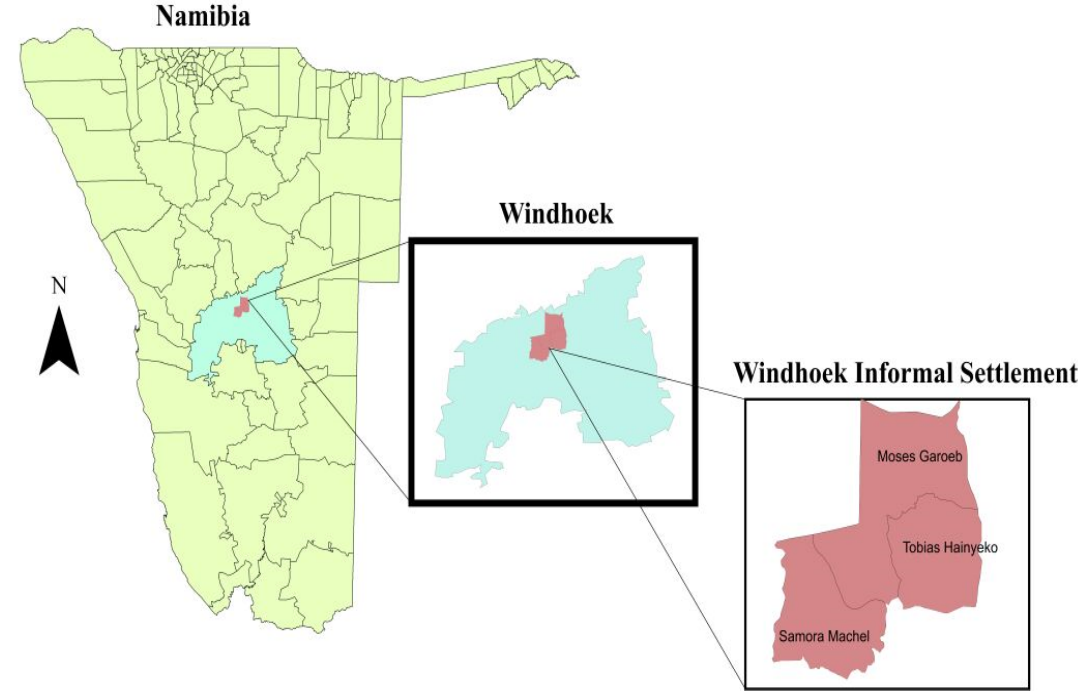
Figure 1. Map of Windhoek informal settlements. Source: [36].